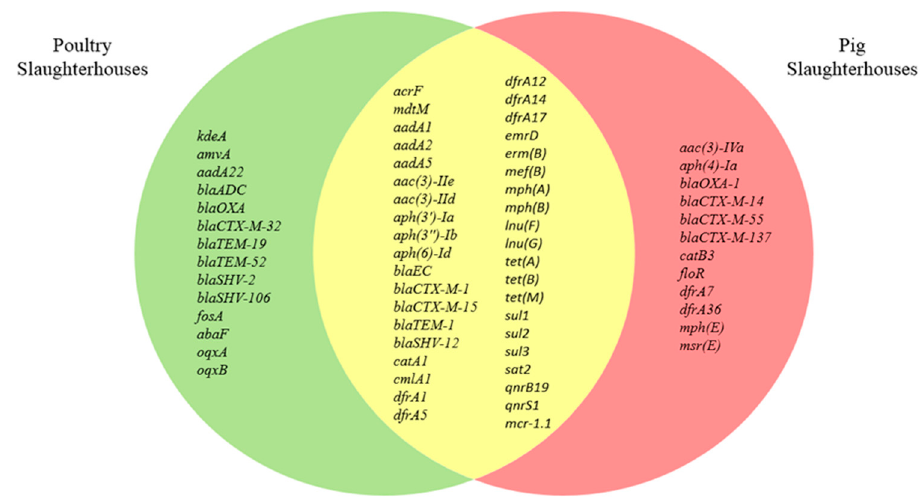
Figure 3. Antibiotic resistance genes identified in selected E. coli isolates ( n = 71) from poultry and pig slaughterhouses.